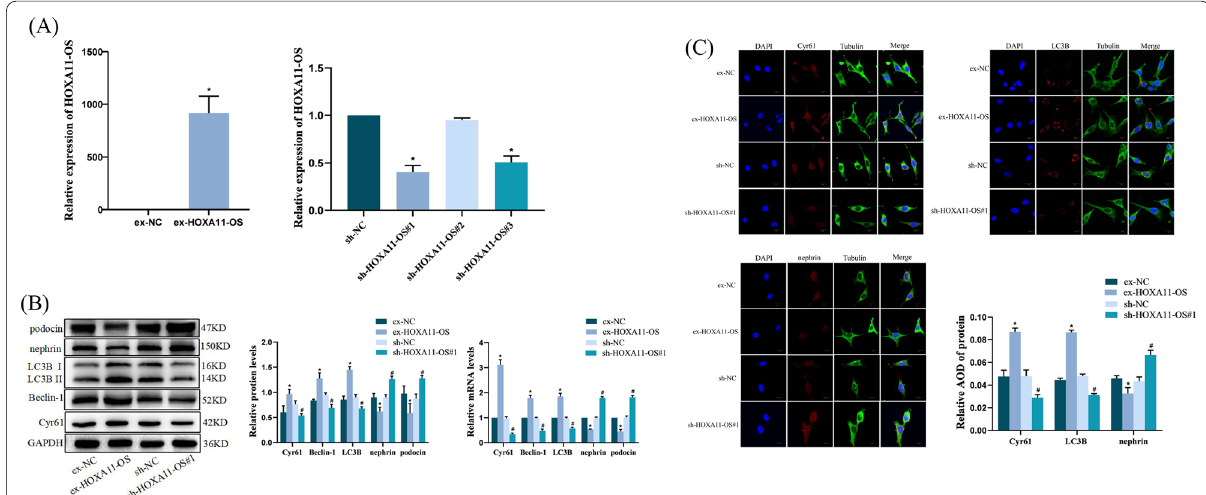
Fig. 2 Expression of Cyr61, autophagy factors, and podocyte markers in podocytes regulated by HOXA11-OS. A HOXA11-OS mRNA expression was detected by qRT-PCR after HOXA11-OS overexpression and knockdown lentiviruses were successfully transfected into podocytes. * P < 0.001 vs. ex-NC; * P < 0.001 vs. sh-NC. B After HOXA11-OS overexpression and knockdown lentiviruses were successfully transfected into podocytes, the expression of Cyr61, Beclin-1, LC3B, nephrin, and podocin was detected by qRT-PCR and western blotting. * P < 0.01 vs. ex-NC; # P < 0.01 vs. sh-NC. C After HOXA11-OS overexpression and knockdown lentiviruses were successfully transfected into podocytes, the localization and expression of Cyr61, LC3B, and nephrin proteins in each group were detected by IF. Relative average optical density; * P < 0.01 vs. ex-NC; # P < 0.01 vs. sh-NC. Scale bars represent 15